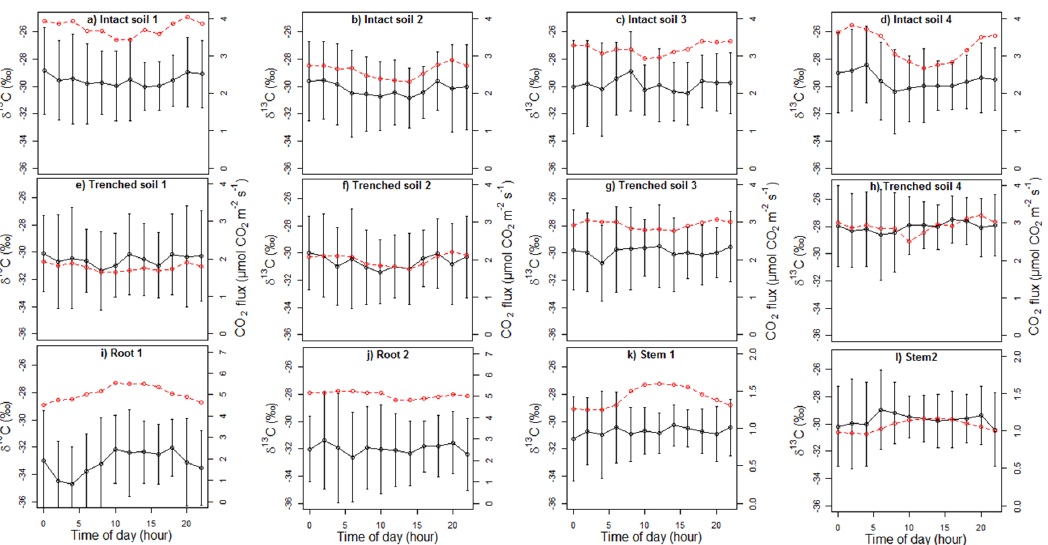
Figure 9. Diel patterns of δ 13 C of the CO 2 fluxes determined by keeling plots ( ± standard deviation, black points and lines) and the CO 2 fluxes (red circles and lines), based on bi-hourly means throughout the measurement period for each of the 12 plots. ( a ) to ( d ) Intact soil 1 to Intact soil 4. ( e ) to ( h ) Trenched soil 1 to Trenched soil 4. ( i ) and ( j ) Root 1 and Root 2, respectively. ( k ) and ( l ) Stem 1 and Stem 2, respectively.